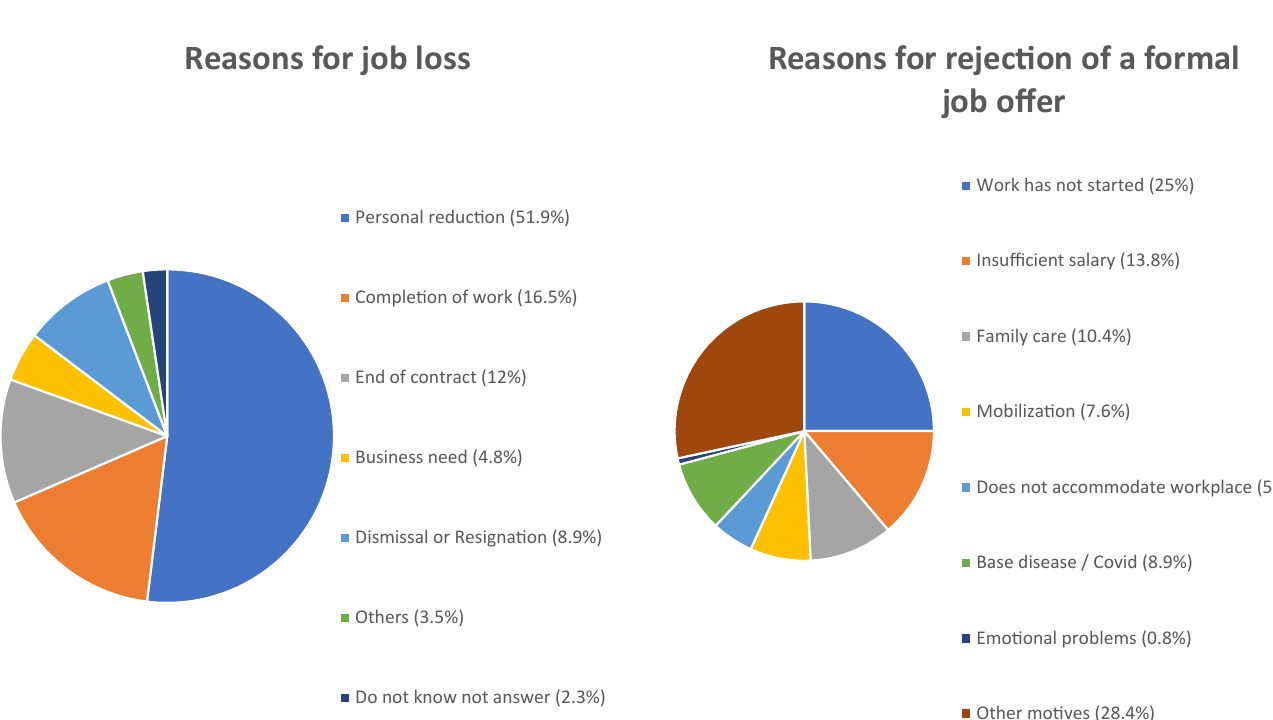
Figure 2. Pie charts on the variables that explain the reasons for losing a job and for rejecting a formal job offer. The results in the graph corresponding to the reasons for rejection of a formal job offer are derived from a subsample of 384 workers.